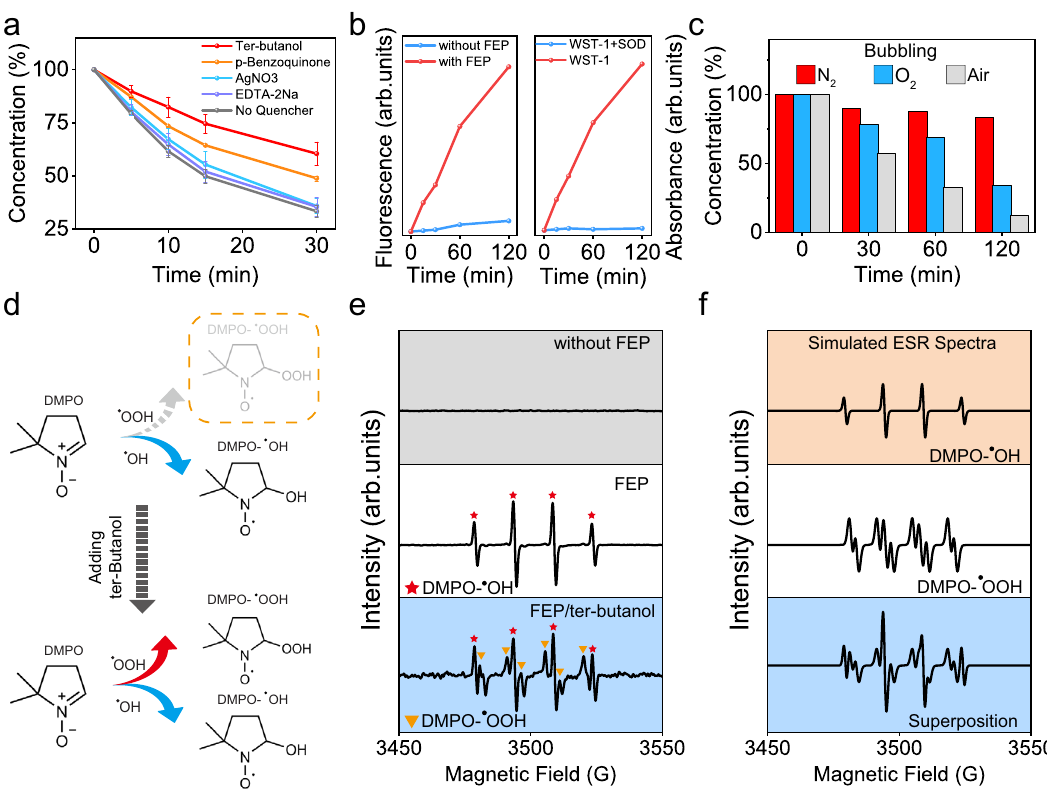
Fig. 3 Investigation on the contribution of radicals to degradation of MO. a Evolution of MO concentration in conditions of various radical scavengers. Ter-butanol, p-benzoquinone, AgNO 3 , and EDTA-2Na, are regarded as superoxide radical, hydroxide radical, electron, and proton scavengers, respectively. b Evaluation of the production of OH and O 2 radicals and their reactivities by the fl uorescence intensity of THA-OH and the absorbance of formazan dye, respectively. c Investigation of the in fl uence of dissolved gas in solution on the degradation of MO. d Schematic of the effect of introducing ter-butanol on the production of DMPO adducts. e Measured EPR spectra under various conditions, and every peak is labeled by corresponding patterns. f Simulated EPR spectra under the same condition by EasySpin . Error bars represent standard deviation based on three replicate